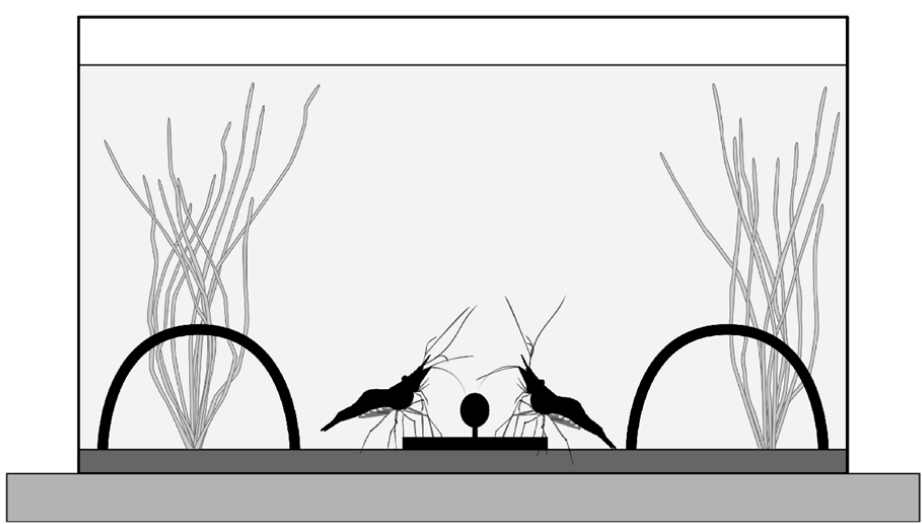
Figure 1. Experimental setup: disposition in the recording tank of shelters and food arena in the middle with a portion of Solea solea, Linnaeus, 1758, anchored to a plate.